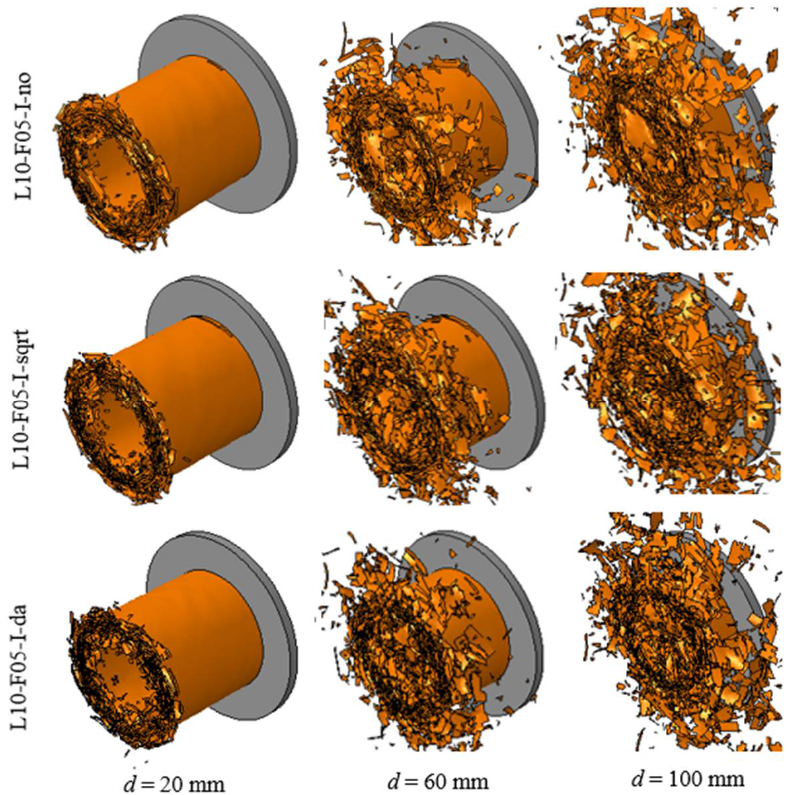
Figure 11. Crushing process of the composite tube simulated using three pairs of inter-layer fracture energy values.